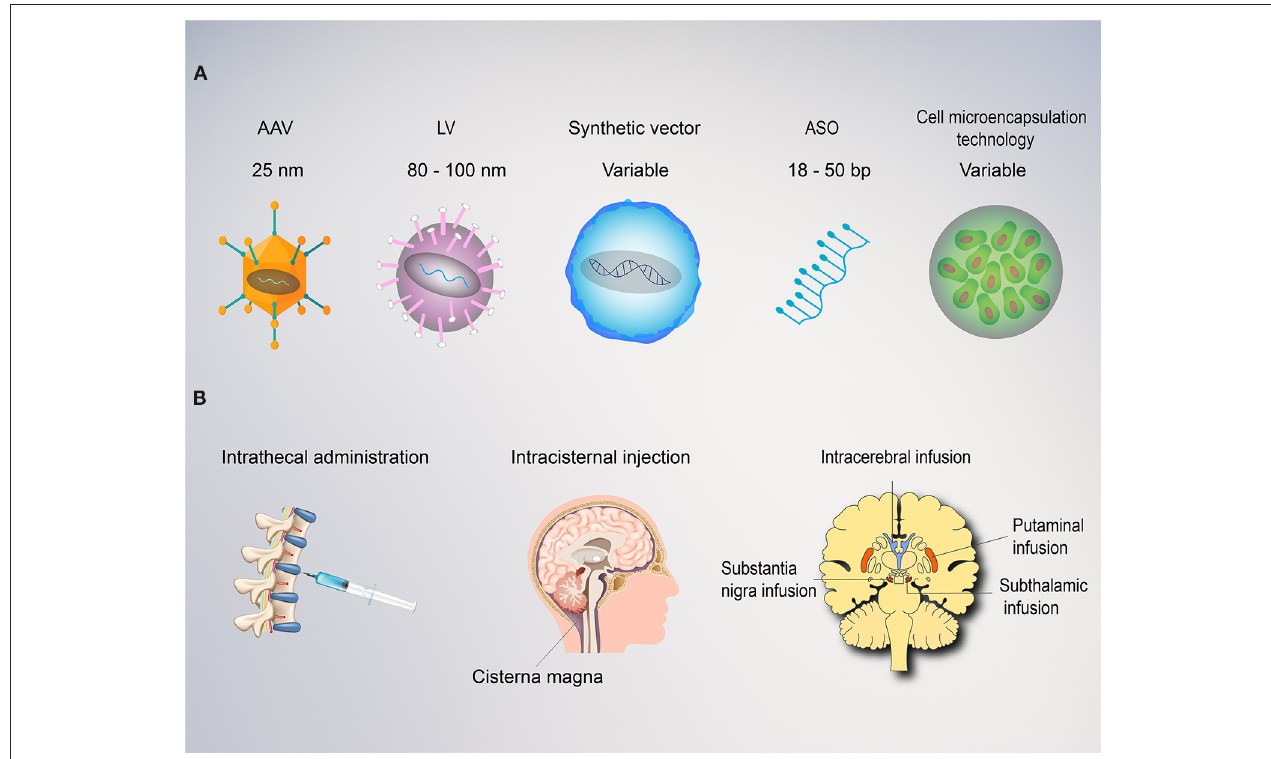
FIGURE 2 | Vectors and route of administration for gene therapy in movement disorders. (A) Both viral and non-viral vectors can be employed for gene therapy. Adeno associated viruses (AAVs) are relatively small with ∼ 4.0kb packaging capacity and lower immunogenic potential when delivered directly to the brain. AAVs replicate primarily as episomes within the nucleus and rarely integrate into the genome with a low risk of insertional mutagenesis. Lentiviruses (LV) are larger with an 8.5kb carrying capacity. LVs utilize reverse transcriptase, allowing the transgene to integrate into the host genome, providing stable, long-term transgene expression, but also carries a higher risk of insertional mutagenesis. Synthetic vectors are characterized by lower immunogenicity and larger carrying capacity, but poor delivery efficiency. Antisense oligonucleotides (ASO) are short, single-stranded synthetically derived oligonucleotides. In application for movement disorders, these are typically designed to bind mRNA to interfere with the mechanism of protein translation and thereby reduce levels of aberrant proteins. Cell microencapsulation technology employ cells genetically engineered to secrete proteins and encapsulated into an immunoisolating material that makes them suitable for transplantation. (B) The route of administration is a critical factor for the success of any movement disorders gene therapy approach. Intrathecal, intraventricular, or intracisternal magna injections provide wide distribution of the vector within the central nervous system, but poor diffusion into the deep regions of the target basal ganglia. This approach requires dilution into large volumes of cerebrospinal fluid and delivery of high titers with a consequent increase in cost and risk of immunogenicity. Intraparenchymal delivery ensure precise delivery and optimal vector distribution within the critical structures involved (i.e., putamina, substantia nigra, and subthalamic nucleus).